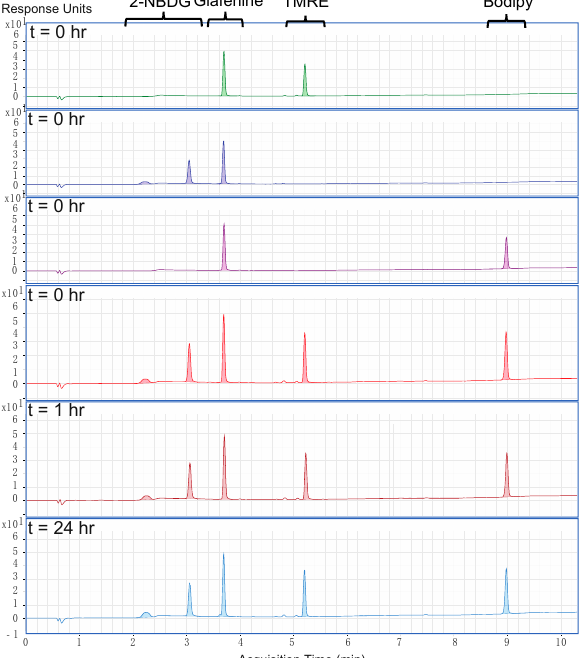
Figure 1. There is no chemical crosstalk between TMRE and Bodipy FL C16. Chromatograms (in descending order) of 100 mM TMRE, 2 ‐ NBDG, Bodipy FL C16, and a mixture of all three at t = 0, the mixture at t = 1 h, and the mixture at t = 24 h. All solutions contained Glafenine (20 μ g/mL) as an internal standard with methanol as a solvent. The peak area was normalized to that of the internal standard. Change in peak area per compound was within 2% (within experimental variability), indicating no chemical change occurs after incubation of the